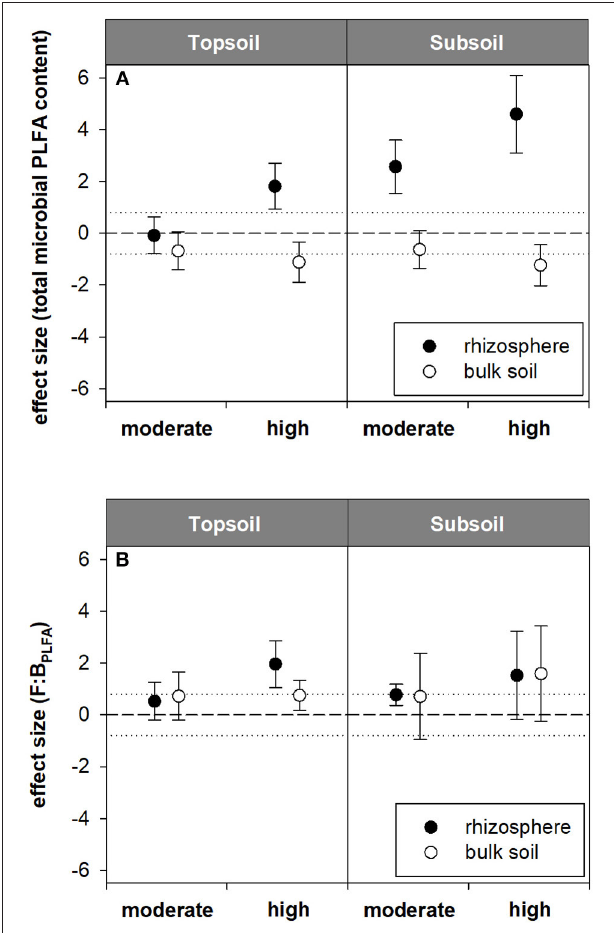
FIGURE 4 | Standardized effect sizes for (A) total microbial PLFA content and (B) F:B PLFA ratio. Hedges’ g* of the exudate addition treatments compared to the water control. Bars indicate the standard error of the effect size estimate. Dotted lines mark thresholds of − 0.8 and 0.8 below or above which, respectively, effect sizes are considered as